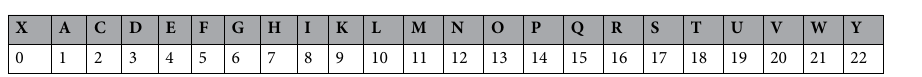
Table 2. Amino acid encoding utilized in this research.